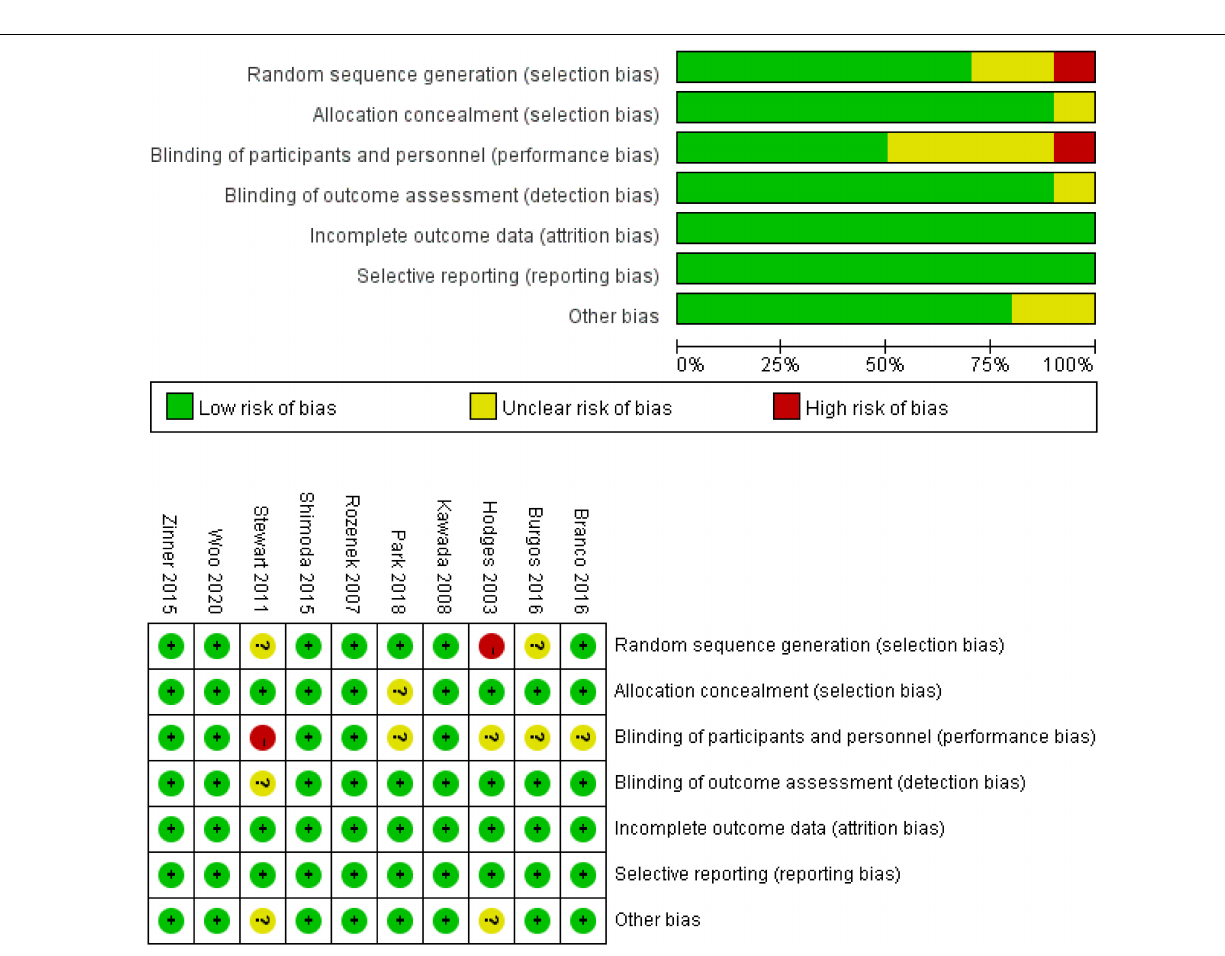
FIGURE 4 | Analysis of the risk of bias in accordance with the Cochrane collaboration